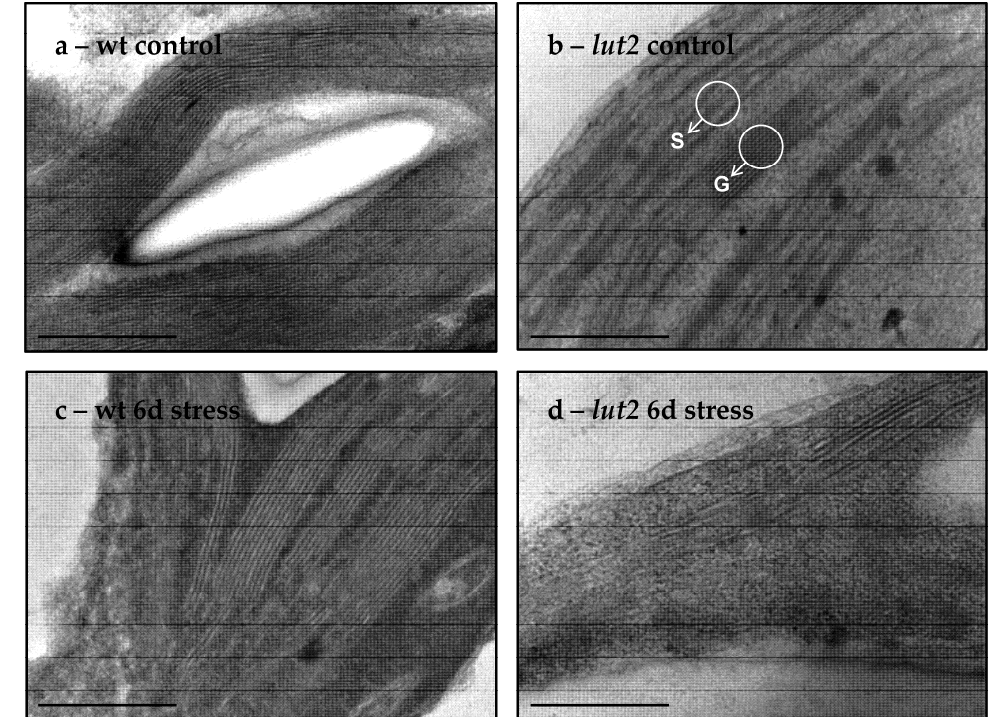
Figure 7. Effect of two stress factors on chloroplast ultrastructure. Typical transmission electron micrographs of mesophyll chloroplasts ultrastructure of wt ( a , c ) and lut2 Arabidopsis mutant ( b , d ) in control, non-treated plants ( a , b ) and after 6 days of treatment with two stress factors (6d stress) ( c , d ). The scale bar is equal to 500 nm. Arrows indicate stromal (S) and granal (G) thylakoids.